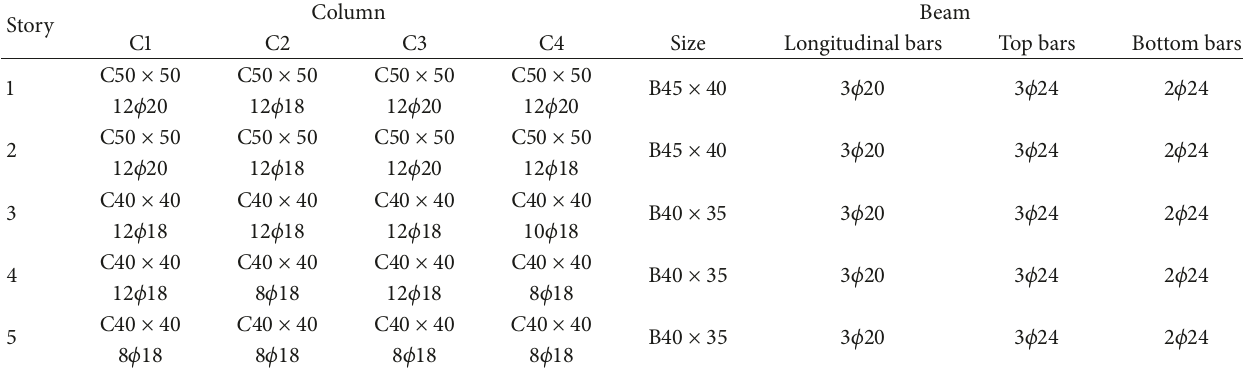
Table 5: Sections for the 5-story RC frame.